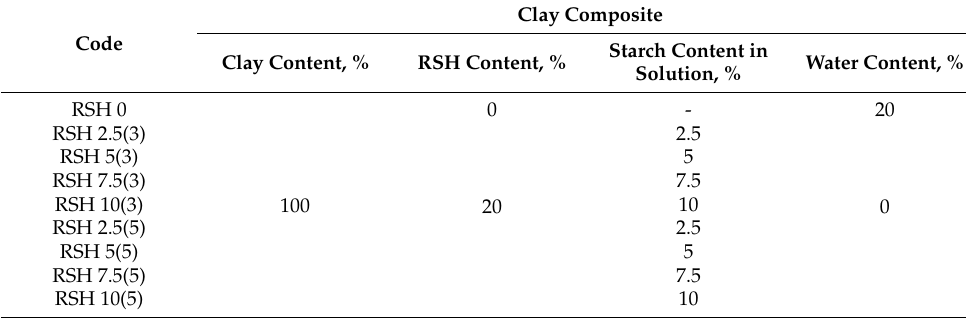
Figure 3. Methodology of RSH and clay composite preparation. Table 4. Mixture of the clay composites.